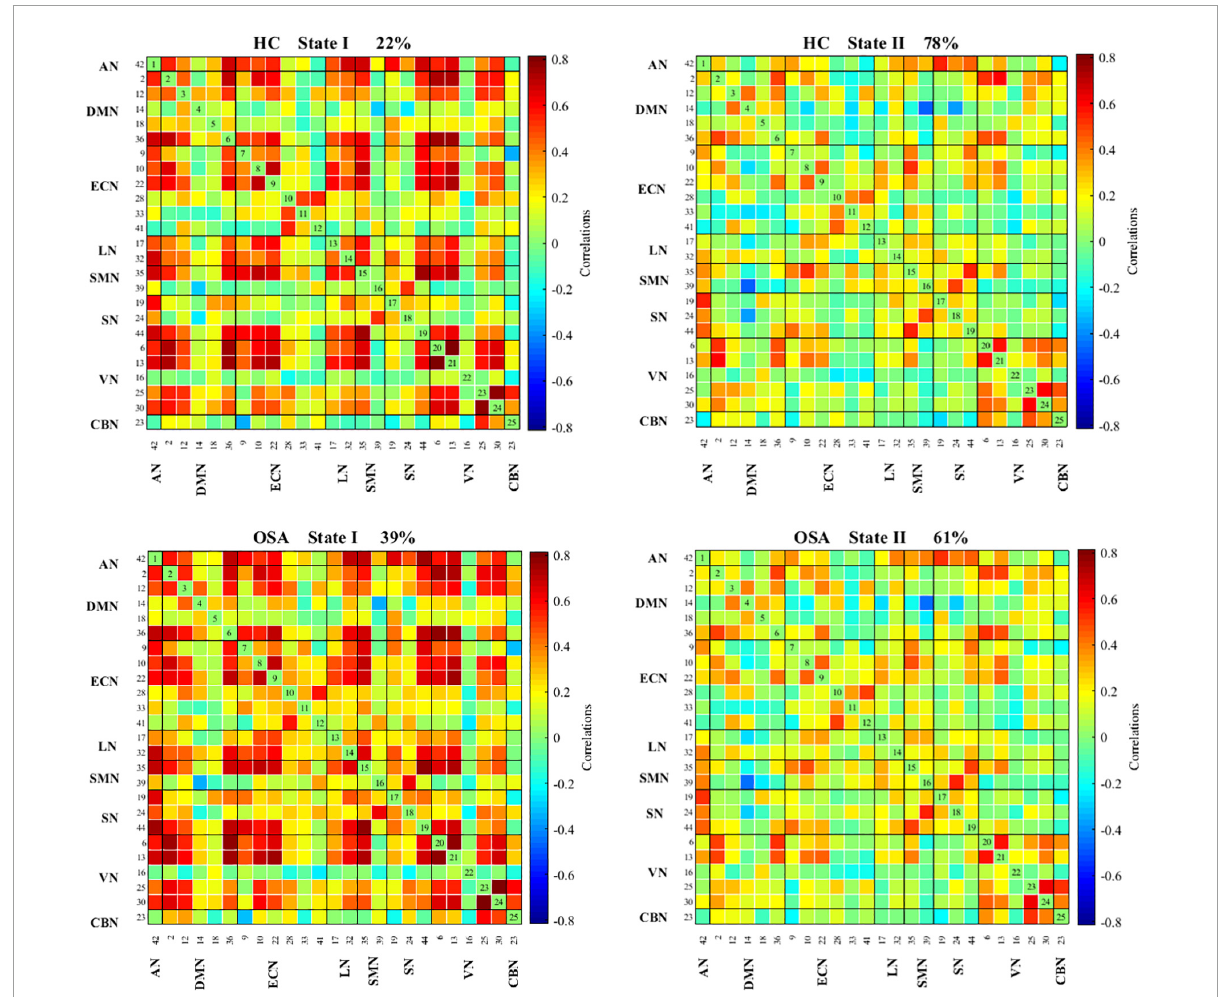
FIGURE4 Functional connectivity state results. Group functional network connectivity matrices for each state (percentage of total occurrences for State I and II: 22 and 78% in the healthy controls and 39 and 61% in the OSA groups, respectively). There are significant statistical differences between two groups ( p < 0.05). AN, auditory network; DMN, default mode network; ECN, executive control network; LN, language network; SMN, sensorimotor network; SN, salience network; VN, visual network; CBN, cerebellar